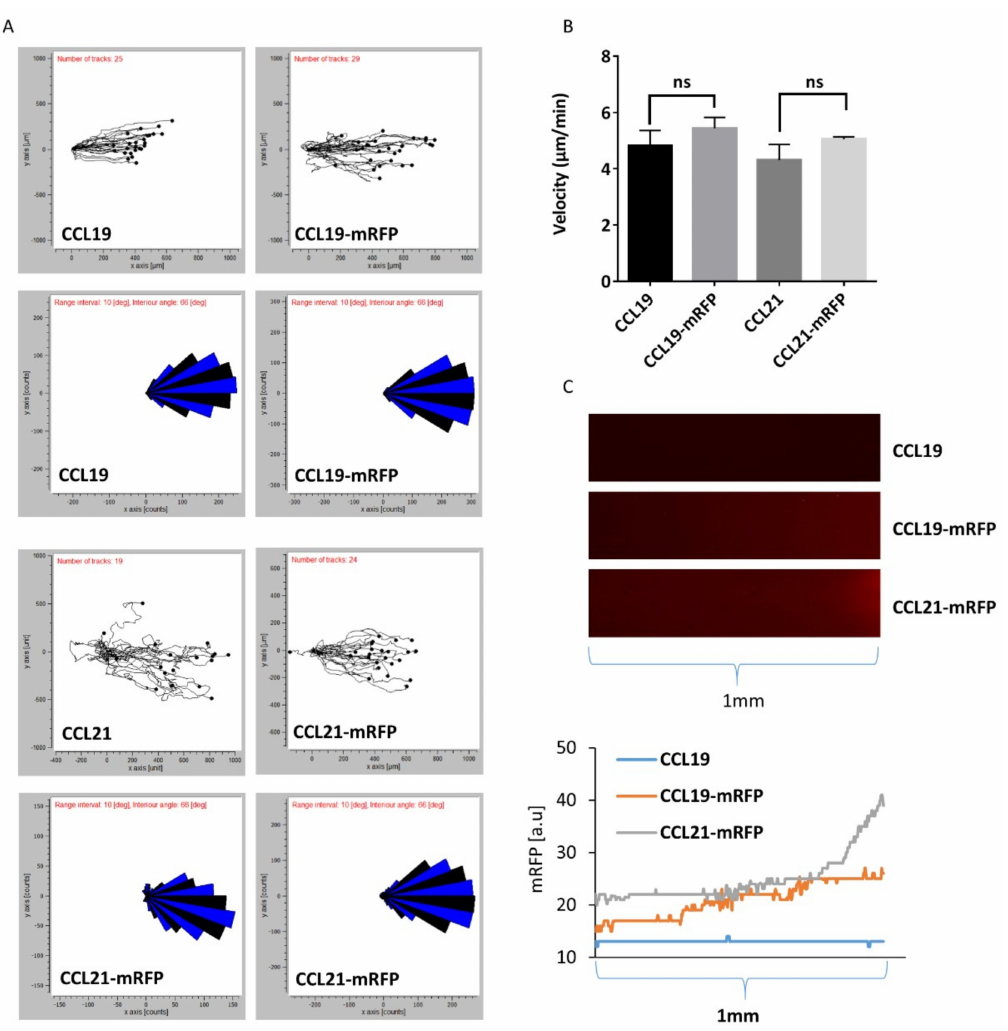
Figure 5. DC migration in 3D collagen along gradients of CCL19-mRFP and CCL21-mRFP. Mouse mature bone-marrow-derived DCs were imbedded in 3D collagen in µ -slide chemotaxis chambers. CCL19, CCL19-mRFP, CCL21, or CCL21-mRFP at 100 nM concentration was applied to the